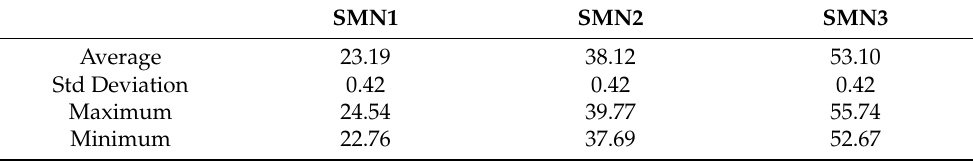
Table 4. Reception timestamps of Smart Measuring Nodes at the Coordinator Node (in